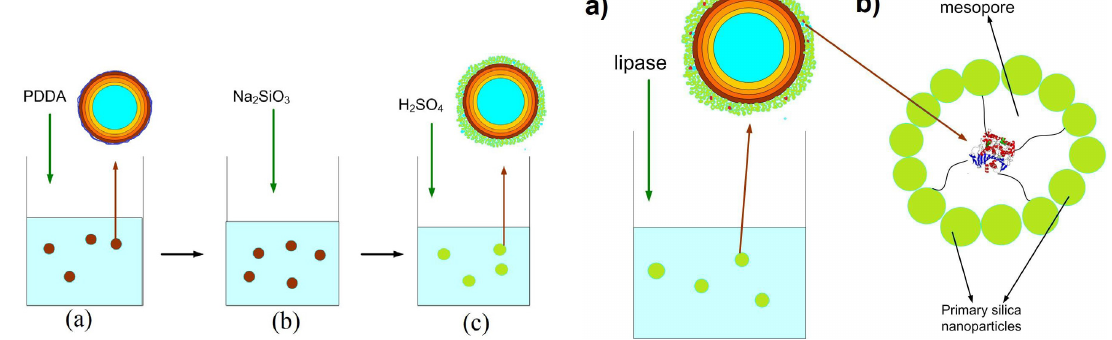
Figure 3. Immobilization scheme: a) immobilization of lipase (red dots) into external mesoporous silica layer; b) covalently bounded lipase inside interparticle